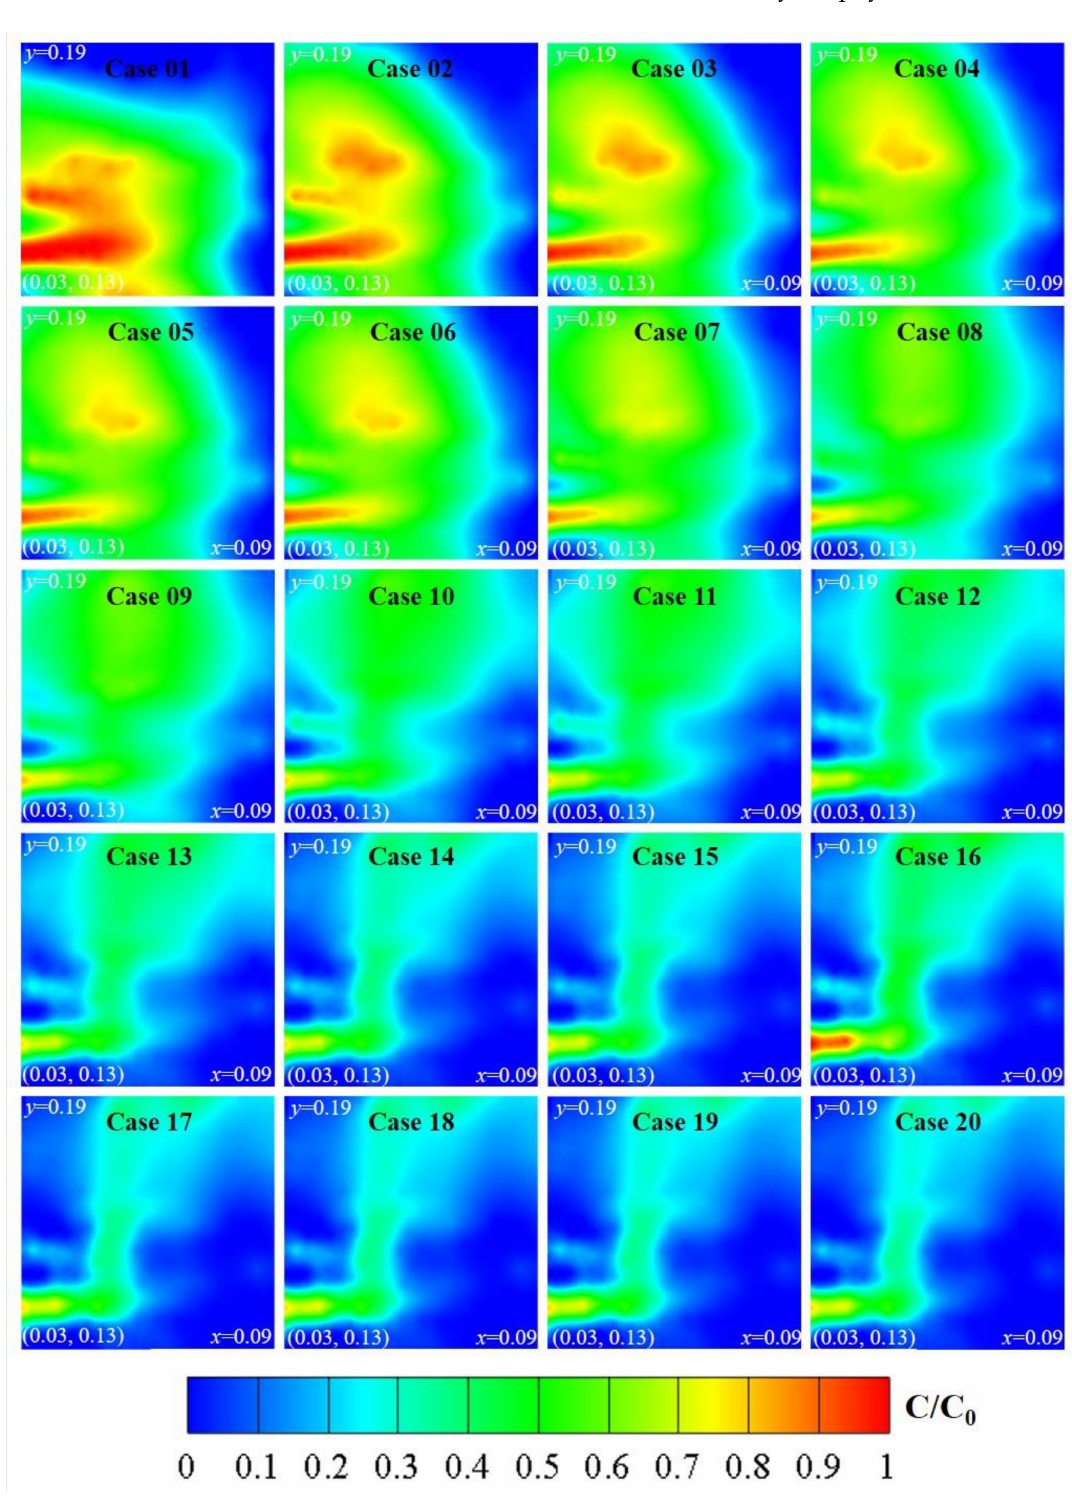
Figure 5. The normalized concentration field at the central plane for different cases obtained by the MGGP